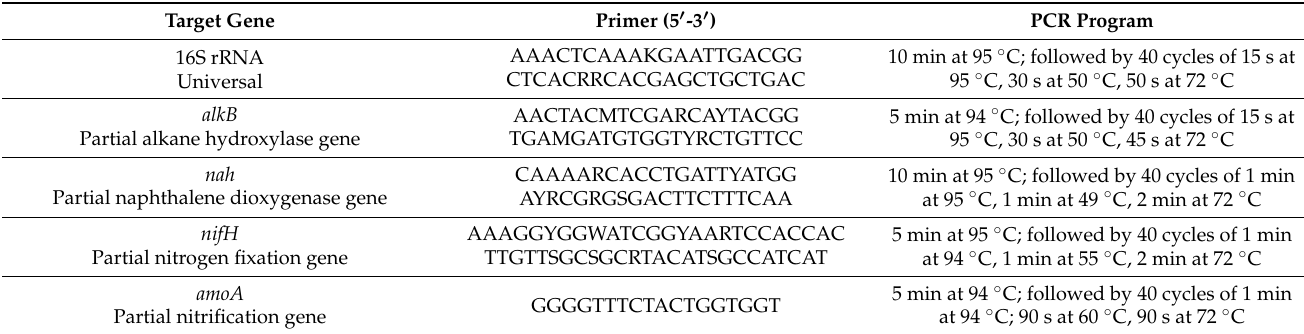
Table A3. The primer sequences and normal PCR